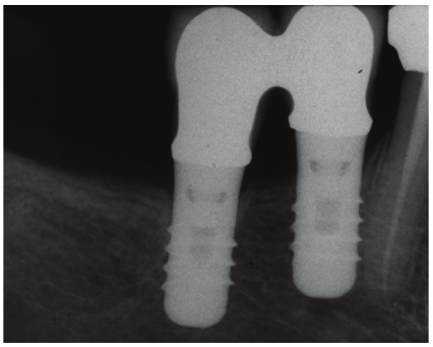
Figure 4: Partial fixed prosthesis supported by short implants (4 . 1 × 8mm): 14 years loading. Periapical